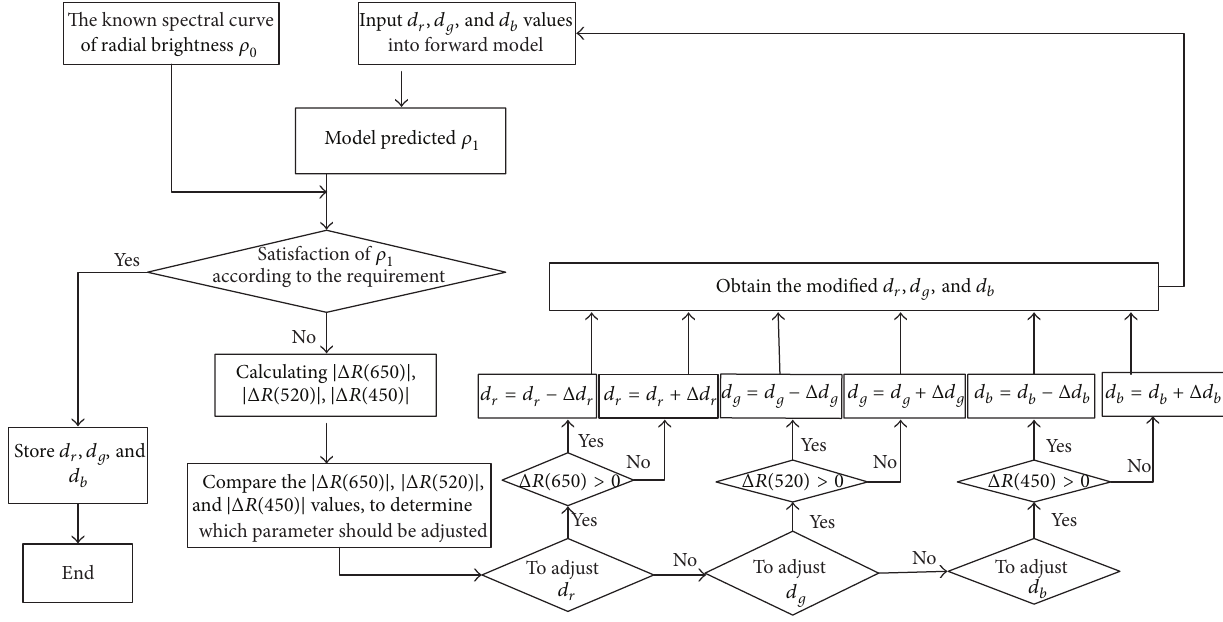
Figure 2: The modifying flow of digital input values 𝑑 𝑟 , 𝑑 𝑔 , and 𝑑 𝑏 .